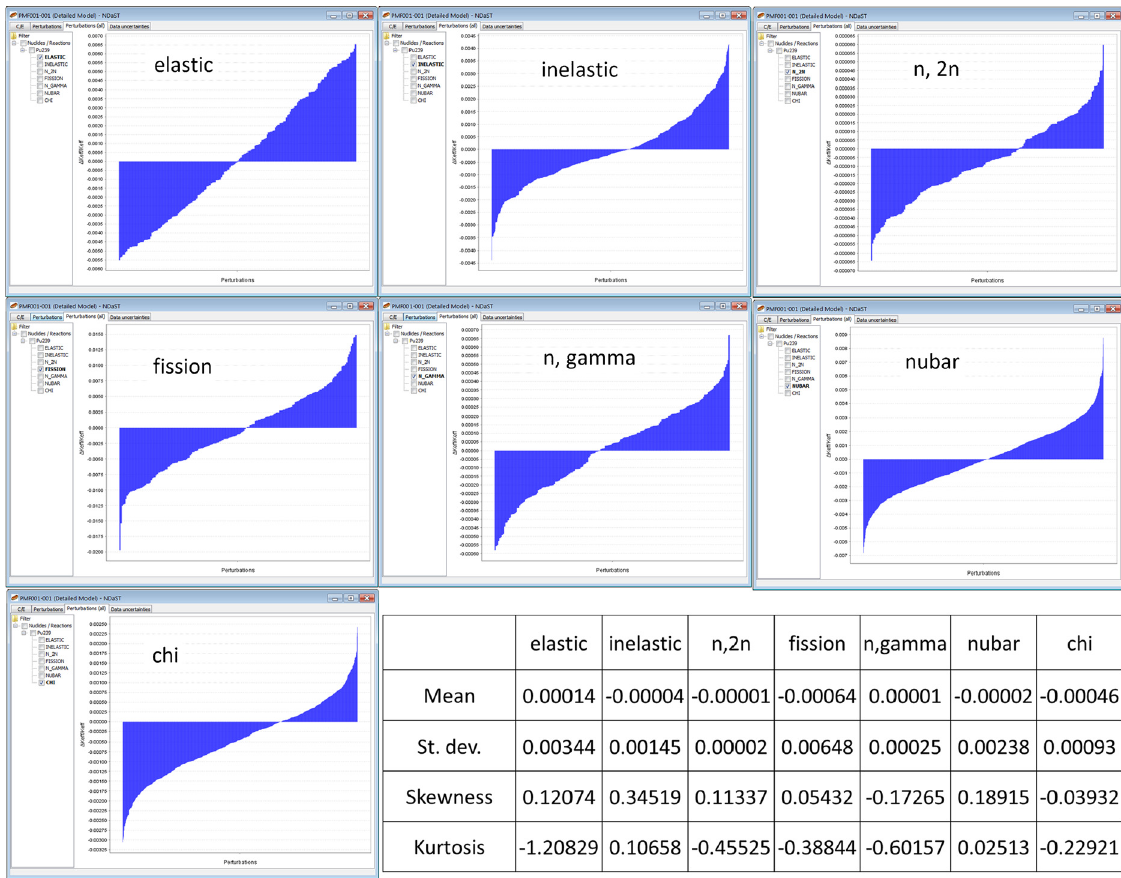
Fig. 3. Comparison of D k eff for NDaST-HMM by reaction, with distribution statistics.